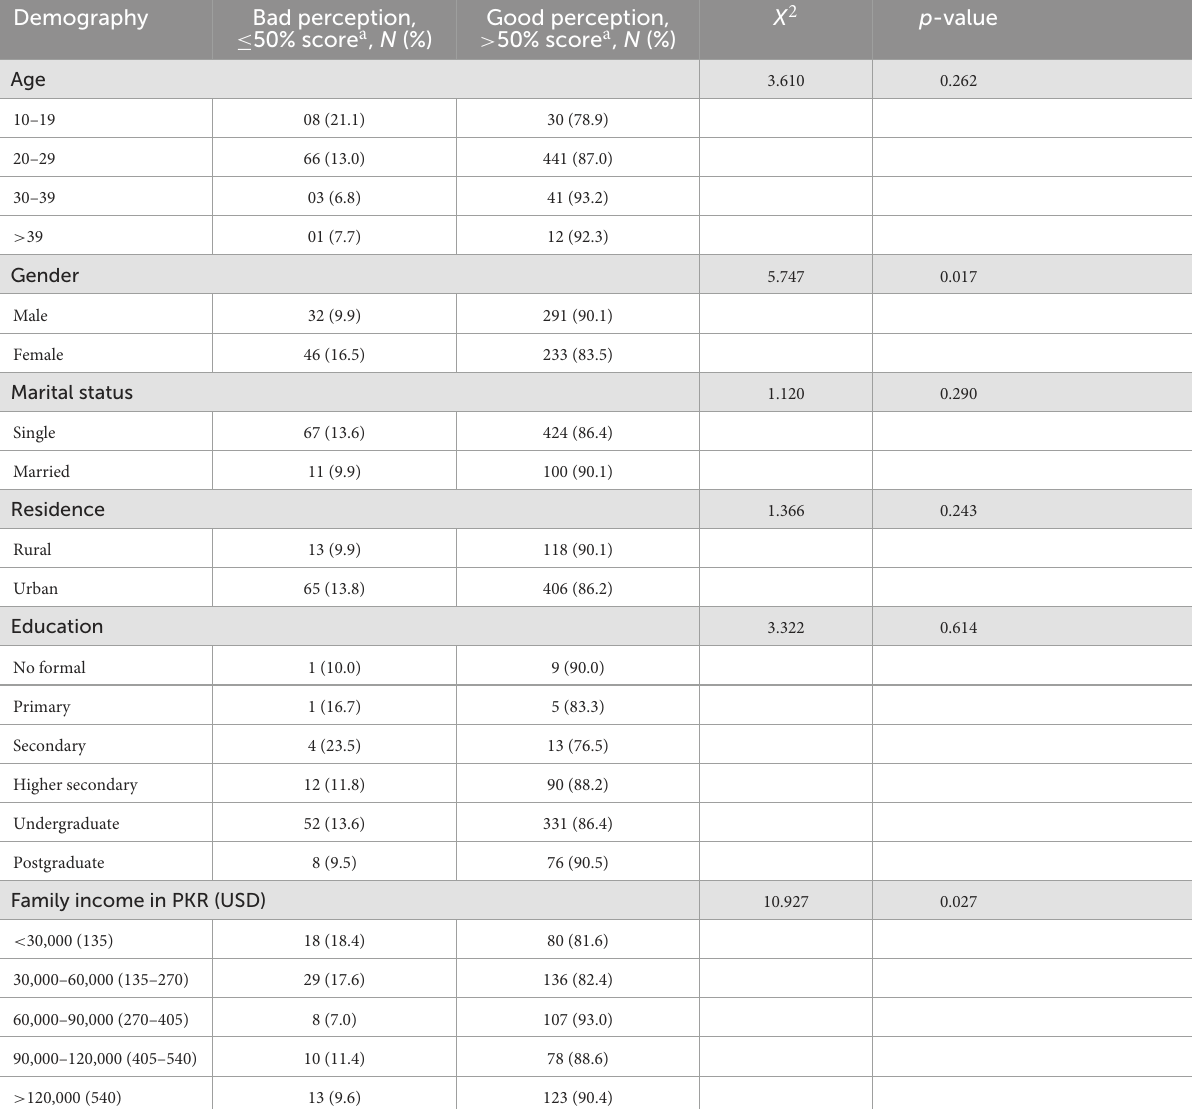
TABLE 6 Association of perception regarding benefits of telemedicine with demographics ( N = 602).